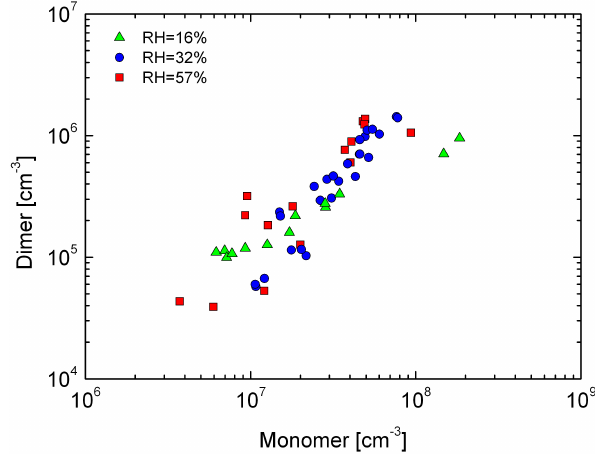
Fig. 3. Sulfuric acid dimer concentration as a function of monomer concentration at three different relative humidities and nucleation temperature T =25 ◦ C. The M/D ratio is increasing from ∼ 100 to ∼ 200 with increasing relative humidity from 16 to 57